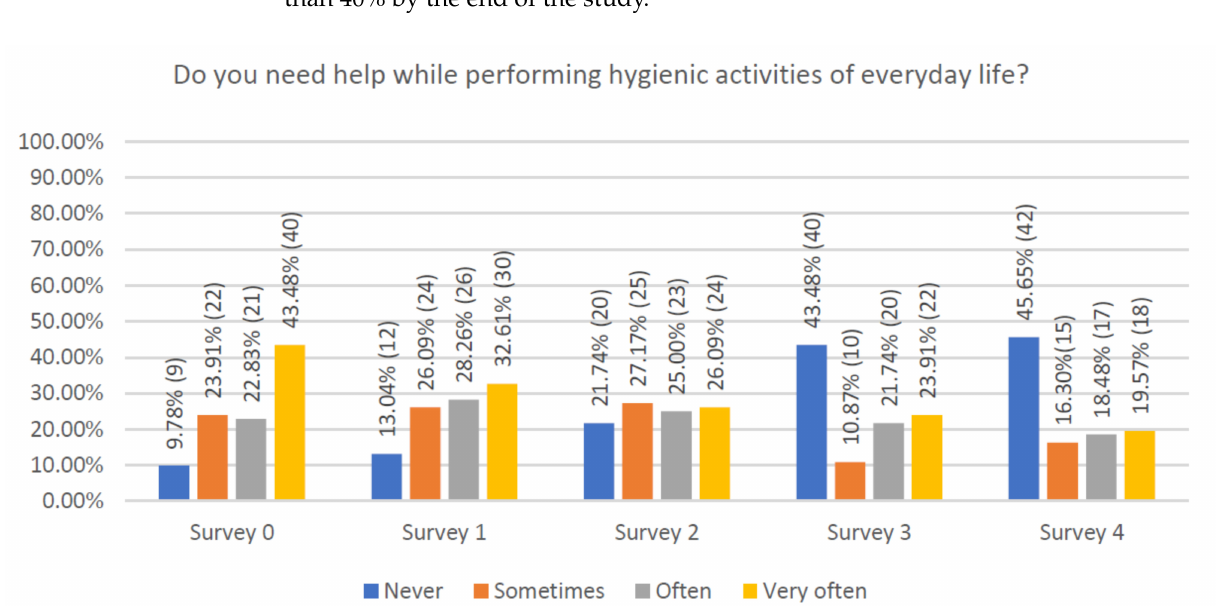
Figure 4. Declaration of respondents regarding help during everyday hygienic